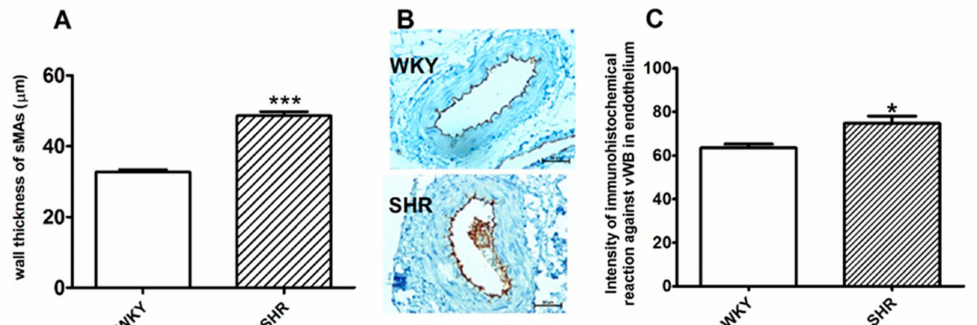
Figure 1. Measurement of medial width ( A ), representative micrographs ( B ) and intensity of the immunohistochemical reaction for the von Willebrand factor (vWF) ( C ) in the small mesenteric arteries (sMAs) from normotensive Wistar Kyoto rats (WKY) and spontaneously hypertensive (SHR) rats. Mean ± SEM of n = 4–5 animals for each bar ( A,C ); * p < 0.05, *** p < 0.001, compared to the WKY; bar = 50 µ m.